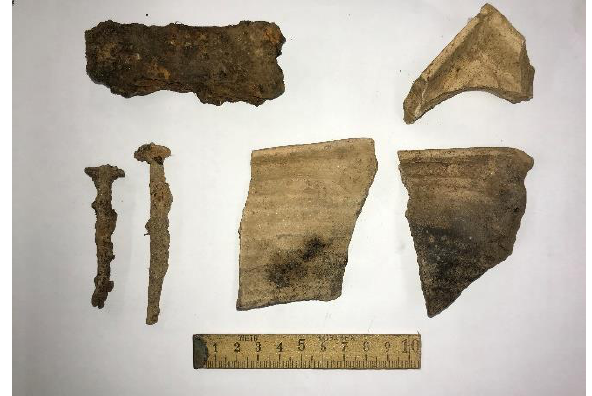
Figure 12. Examples of finds from the looted site: ceramic shard, nails, and a fraction of a mining hammer. Based on (Malina,2015) these artifacts can be dated to the sixteenth – seventeenth century.